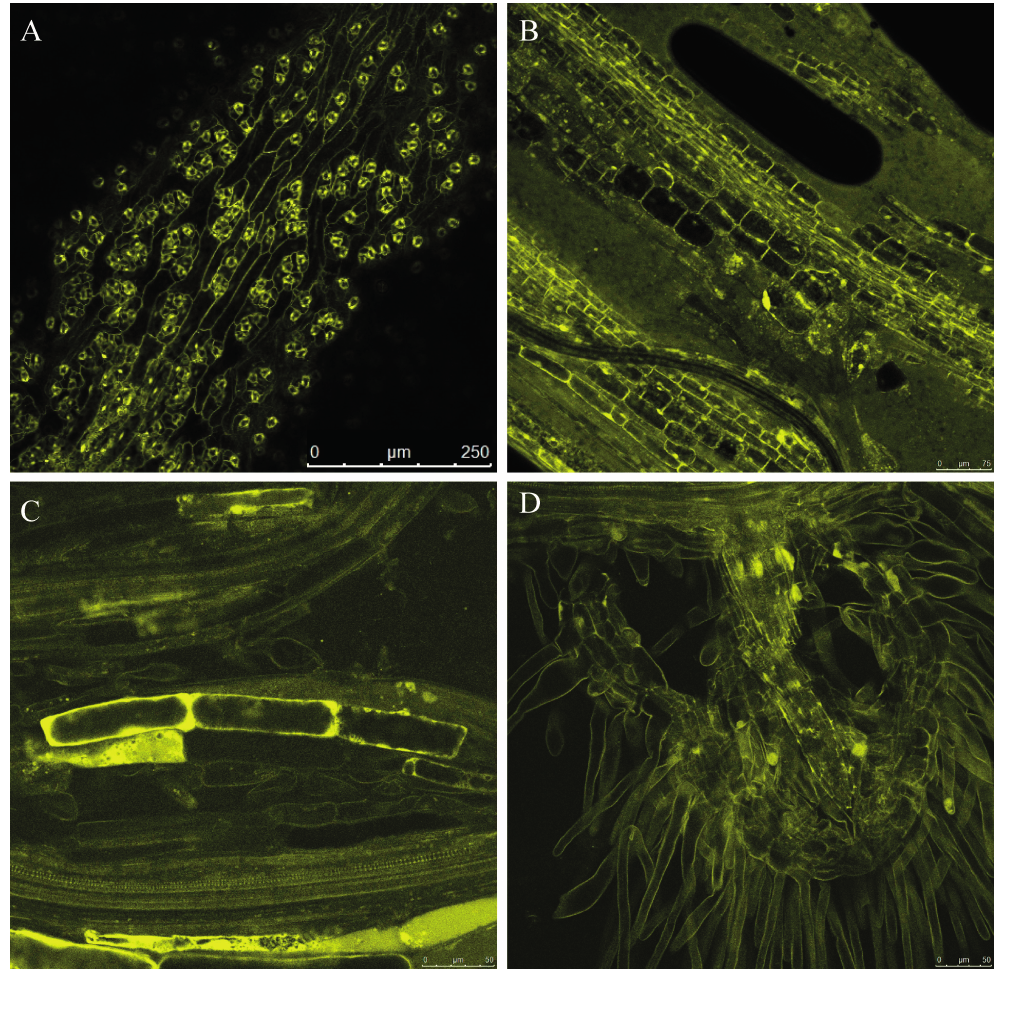
Arabidopsis leaf epidermal cells ( A ); stem ( B ); roots ( C ) and root hairs ( D ). Scale bar